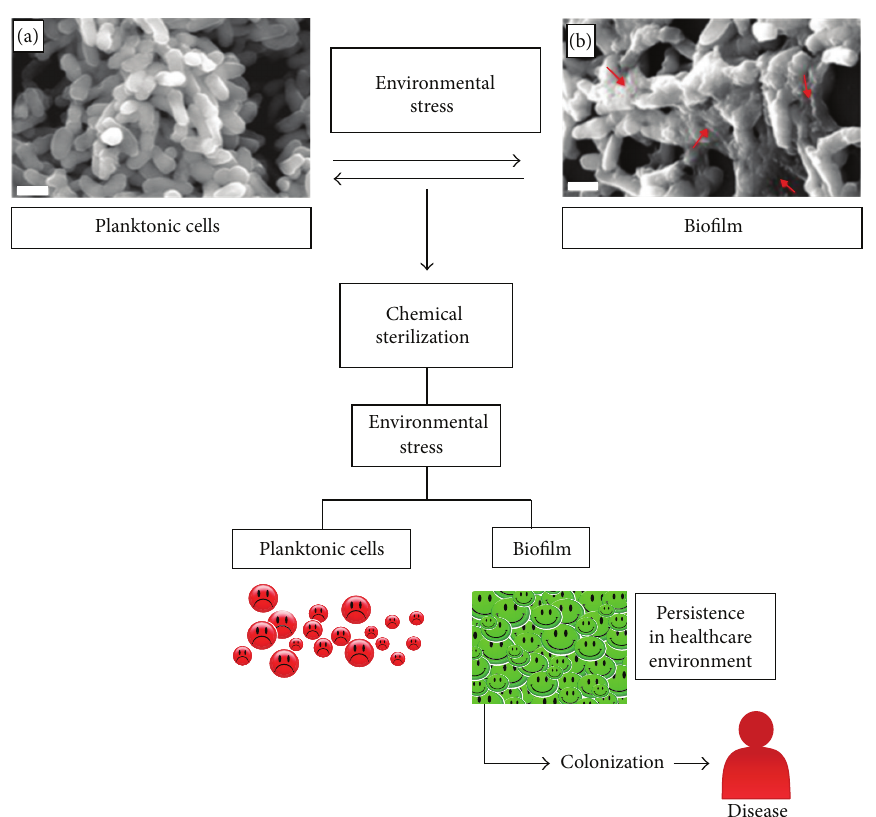
Figure 1: NTM persist in a steady state between planktonic (a) and biofilm (b) within healthcare units and on medical devices. Biofilm assembly is triggered by environmental stress. Bacteria organized in biofilm exhibit a different structure being notorious, increasing the amount of extracellular matrix (red arrows). Another feature of these bacteria is the increased resistance to chemical sterilization, which leads to persistence within healthcare units, host colonization, and onset of disease. (Red circles: dead bacteria; green circles: live bacteria; scale bar 1 𝜇